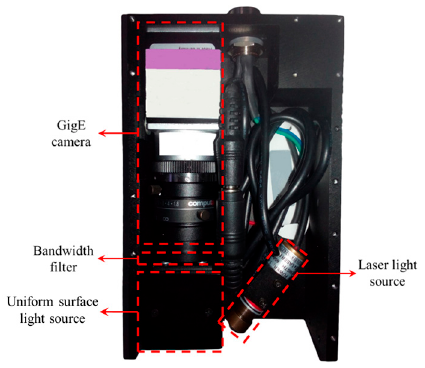
Figure 15. Configuration of the established narrow butt detection sensor.